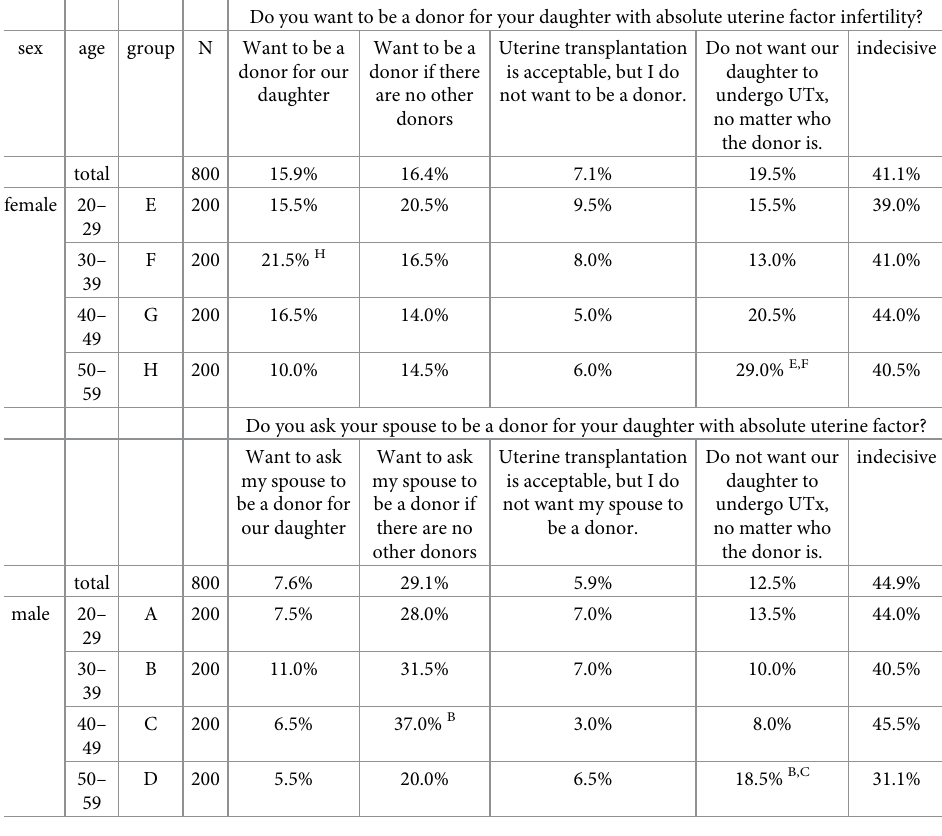
Table 12. Do you want to be a donor for your daughter with absolute uterine factor infertility? sex age group N Want to be a Want to be a Uterine transplantation Do not want our donor for our donor if there is acceptable, but I do daughter daughter are no other not want to be a donor. donors